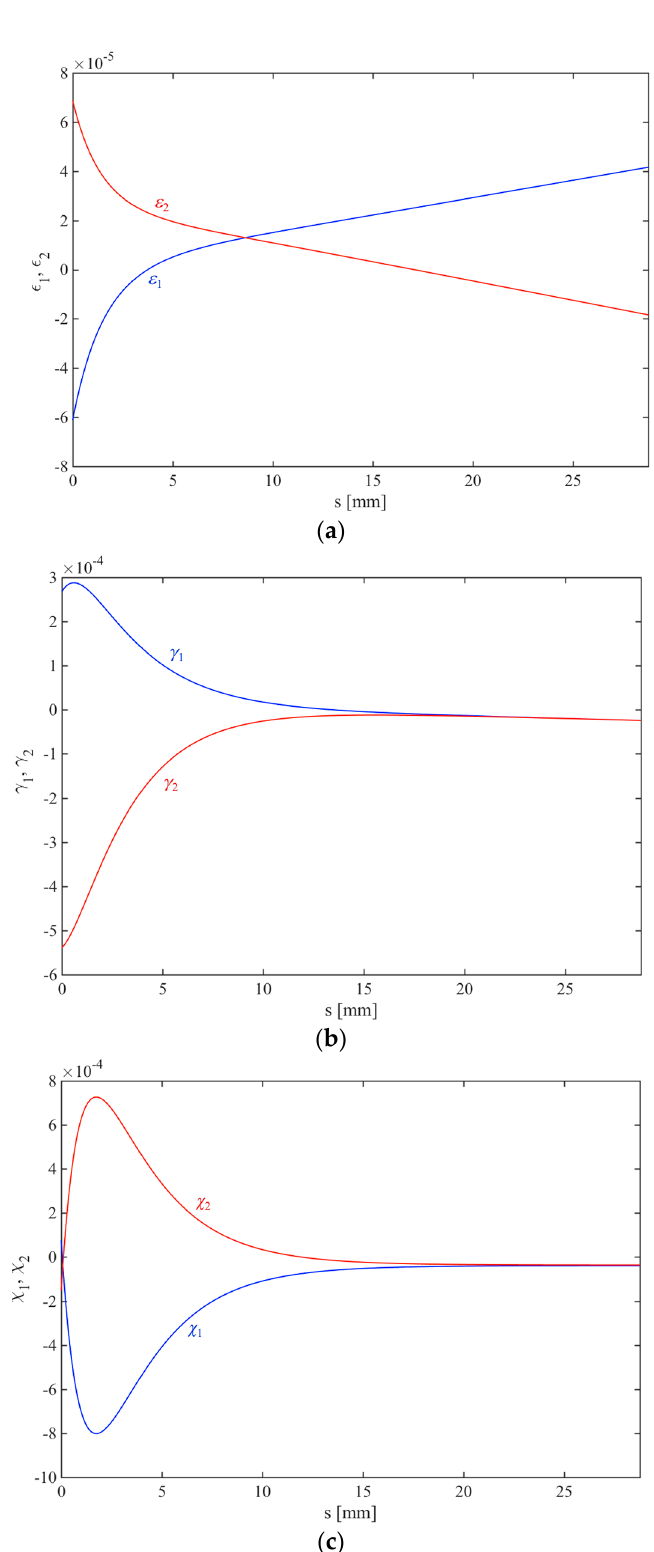
Figure 25. Composite specimen: ( a ) Axial strain; ( b ) Shear strain; ( c ) Curvature.